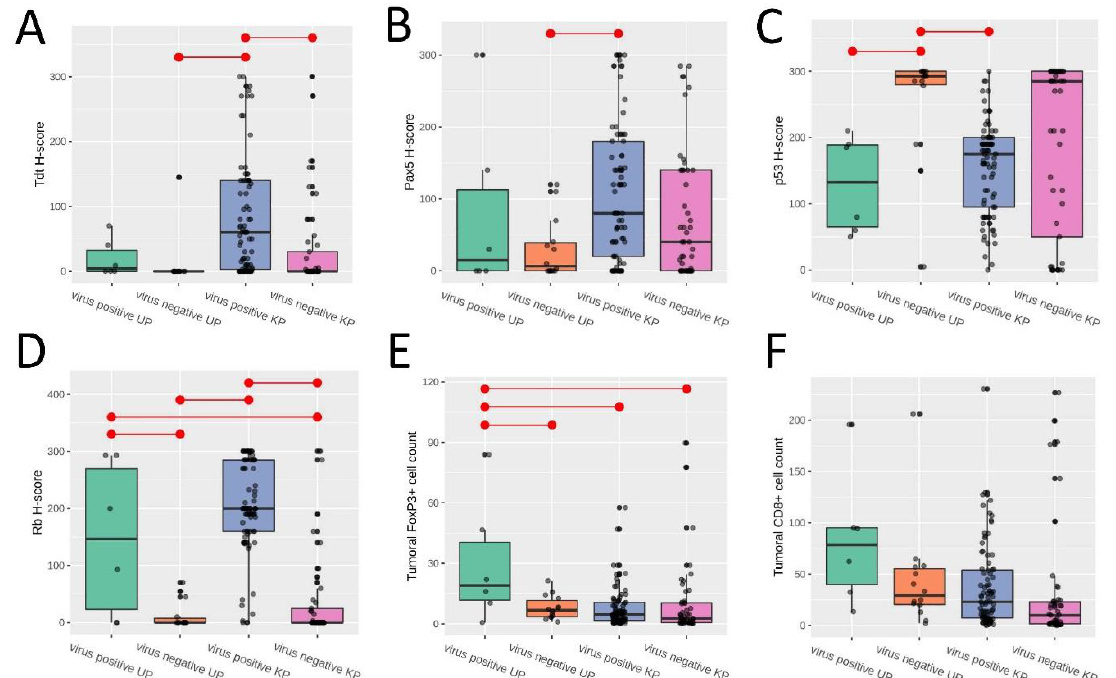
Figure 3. A comparison of the four groups: Merkel cell polyomavirus (MCPyV)-positive unknown primary (UP); MCPyV- negative UP; MCPyV-positive known primary (KP); and MCPyV-negative KP. ( A ) A box plot of TdT nuclear H -score. The box is limited by the 25th and 75th percentiles, and the black bar represents the median line. Connecting bars indicate statistical significance between groups. Boxplots of the ( B ) Pax5 nuclear H -score, ( C ) p53 nuclear H -score, ( D ) Rb nuclear H -score, ( E ) intratumoral FoxP3+ cell count, and ( F ) intratumoral CD8+ cell count.